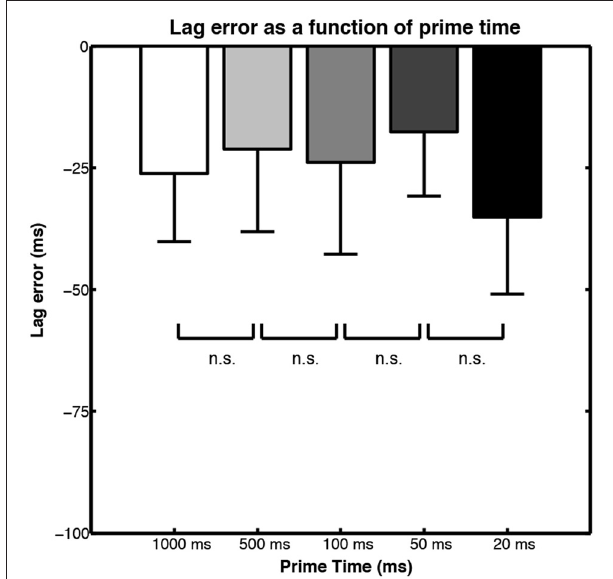
FIGURE 8 | Bar graphs of lag error in action simulation motion judgments when different durations of motion are shown prior to occlusion. Figure adapted from Parkinson et al. (2012, p. 426). Copyright © Springer Science + Business Media. Adapted with